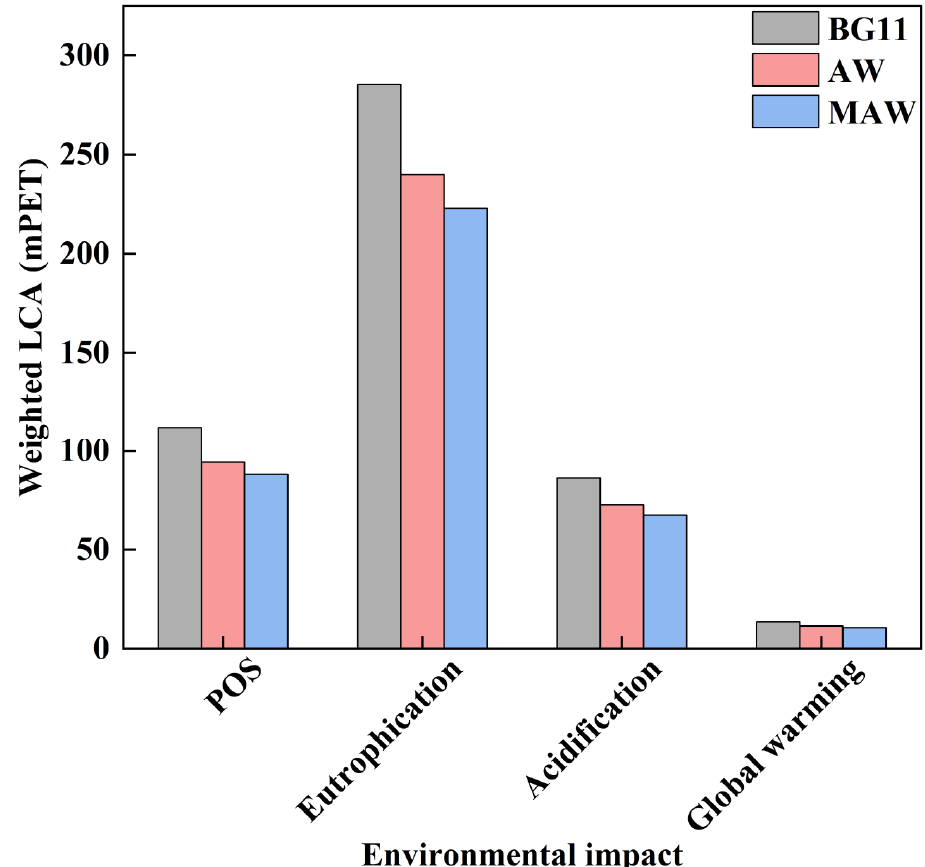
Figure 6. Weighted life cycle assessment of three kinds of medium. POS represents the impact of photochemical ozone synthesis.